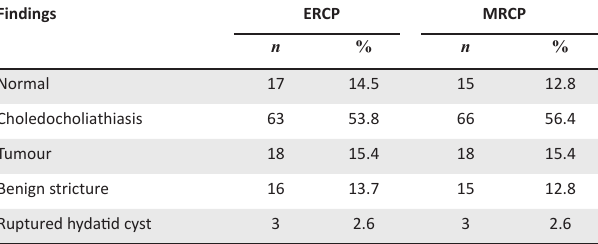
TABLE 1: The distribution of findings in 117 patients with obstructive biliary disorders on both endoscopic retrograde cholangiopancreatography and magnetic resonance